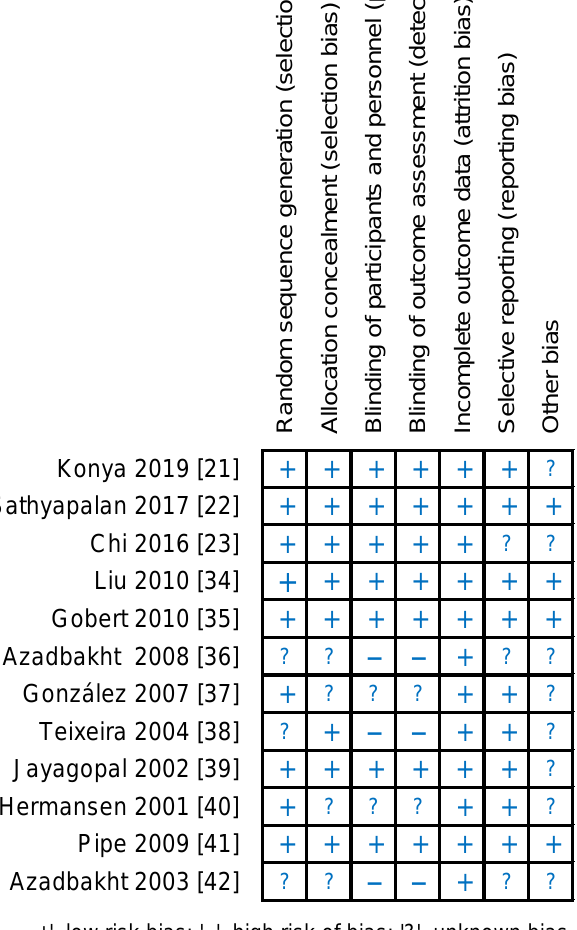
Figure 2. Risk of bias summary for each study-as assessed by the authors.